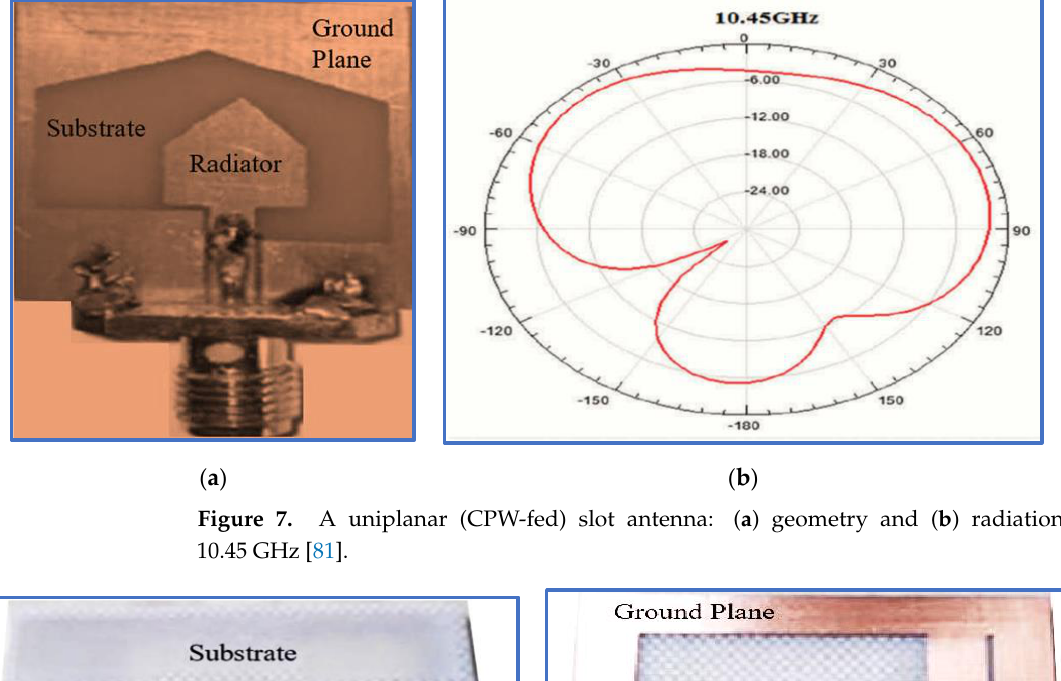
Figure 7. A uniplanar (CPW-fed) slot antenna: ( a ) geometry and ( b ) radiation pattern at 10.45 GHz [81].